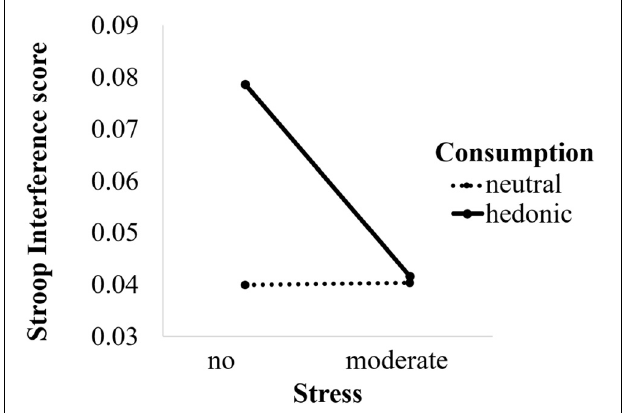
FIGURE 1 | Effects of stress and consumption type on Stroop